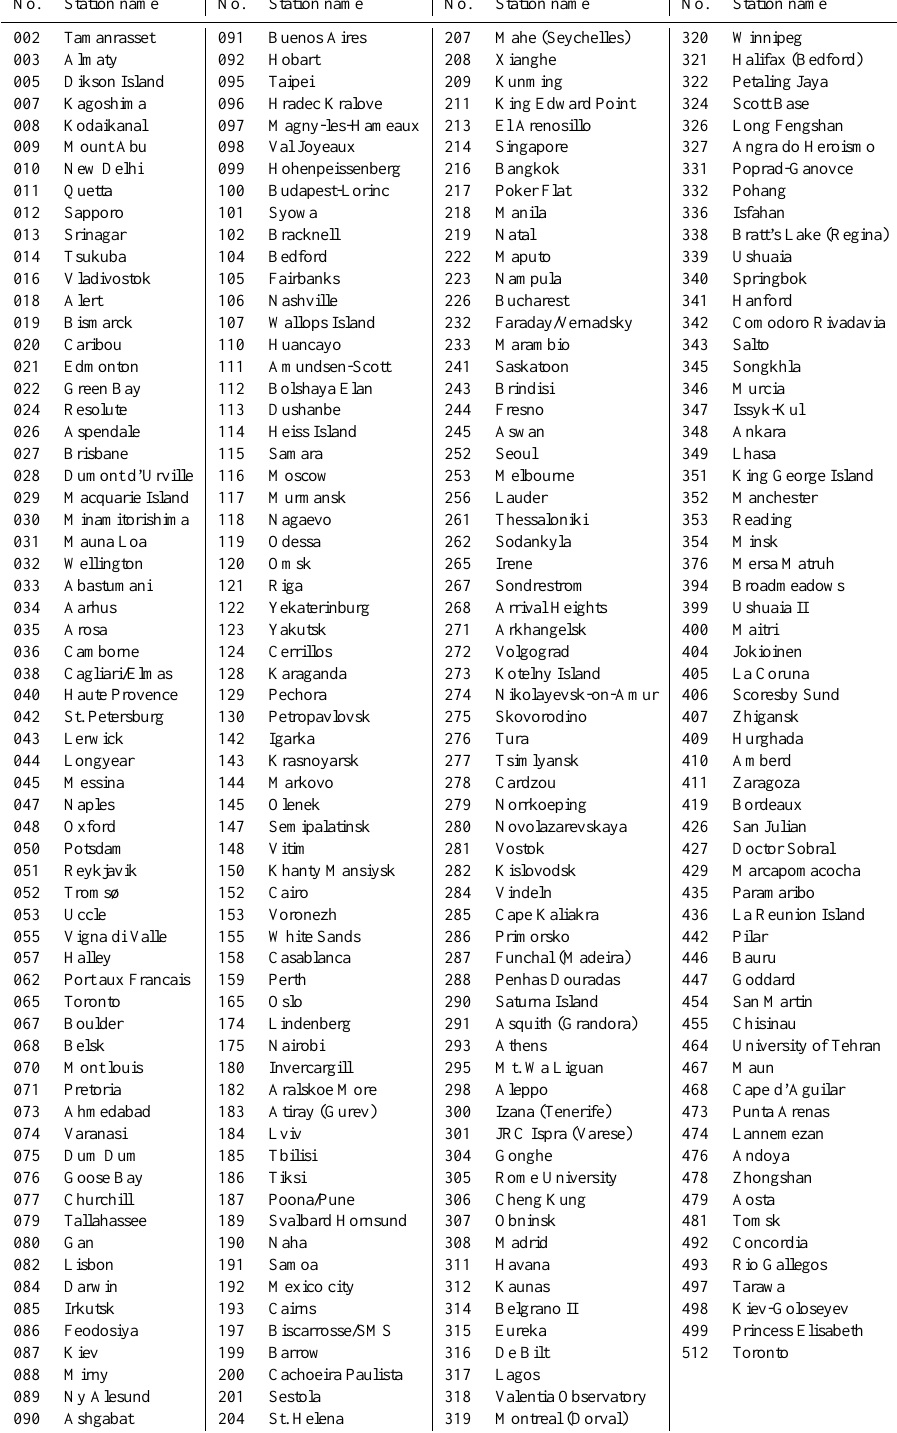
Table A1. List of ground stations used in this study, showing the WMO number of the station and its name. No. Station